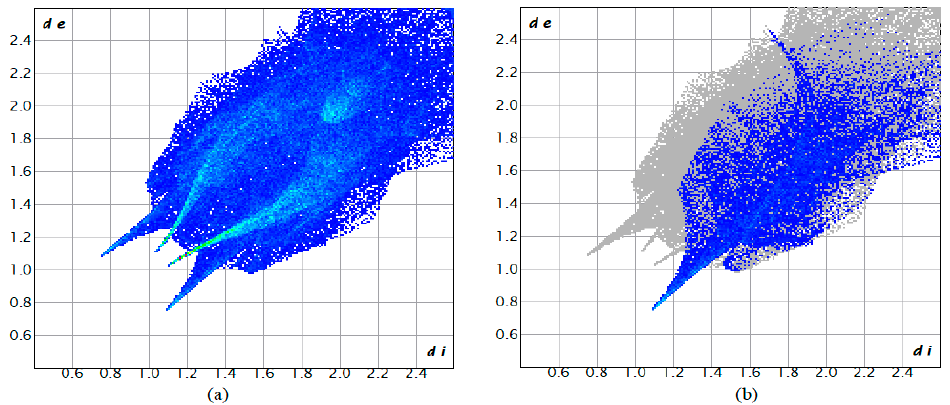
Figure 5. ( a ) Two-dimensional fingerprint plots for all contacts. ( b ) Two-dimensional fingerprint plot only for the O···H interactions.